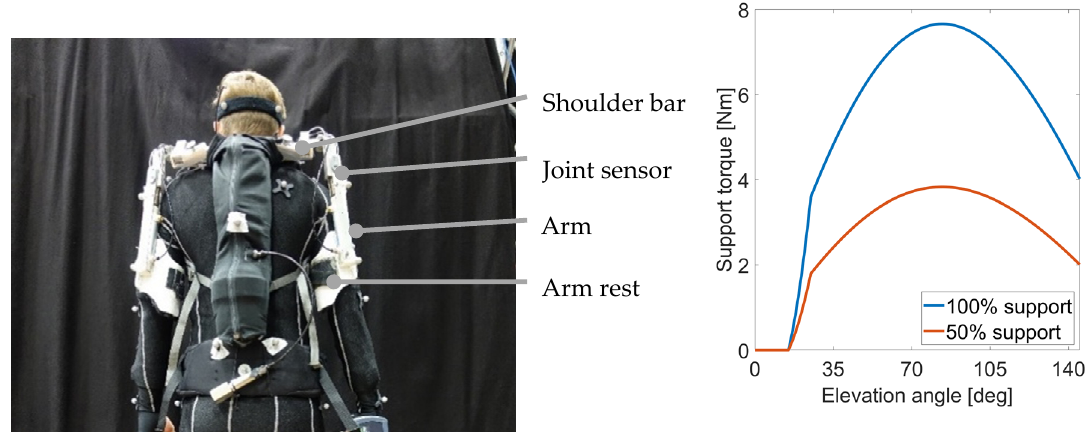
Figure 2. ( Left ) exoskeleton Lucy. ( Right ) Torque–elevation curve for two different support levels: 50% and 100%.